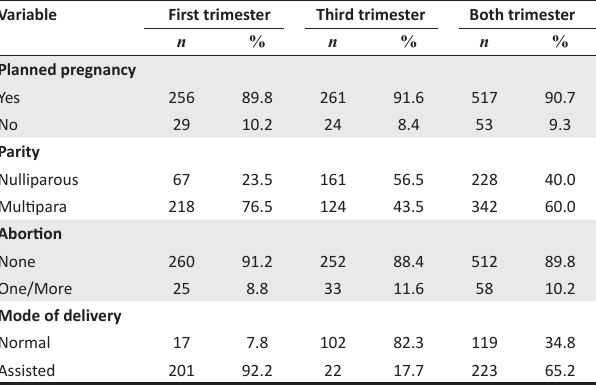
TABLE 2: Obstetrics and gynaecological variable in pregnant